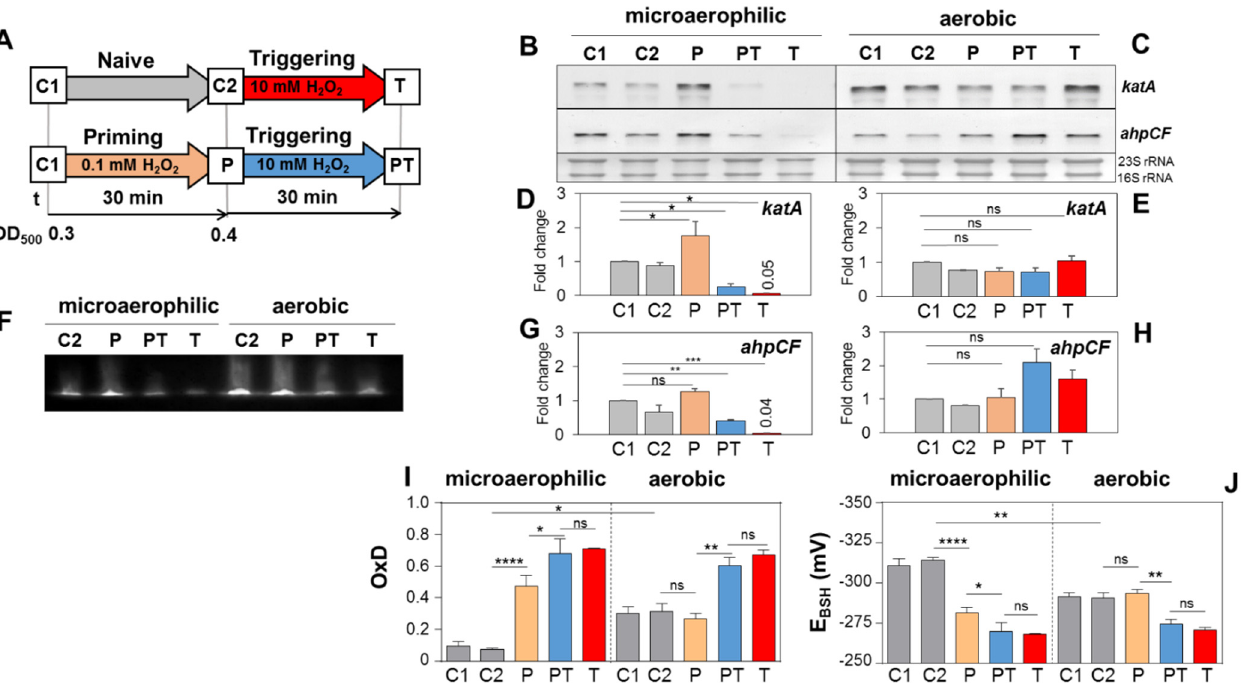
Figure 5. Microaerophilic H 2 O 2 priming leads to increased katA transcription and KatA activity, as well as fast Brx-roGFP2 biosensor oxidation. ( A ) The setup for microaerophilic and aerobic priming and triggering experiments included priming with 0.1 mM H 2 O 2 and triggering with 10 mM H 2 O 2 . ( B , C ) To analyze transcription of katA and ahpCF using Northern blots, RNA was isolated from S. aureus WT cells in the naïve (C1, C2), primed (P), primed and triggered (PT) and triggered (T) states. The band intensities of the katA ( D , E ) and ahpCF specific transcripts ( G , H ) were quantified from two biological replicates using ImageJ. The transcriptional induction of katA and ahpCF was calculated as fold change relative to the control C1, which was set to 1. Error bars represent the SD. The statistics were calculated using ordinary one-way ANOVA and Dunnet’s multiple comparisons test in Graph Prism. Symbols: ns p > 0.05; * p ≤ 0.05; ** p ≤ 0.01 and *** p ≤ 0.001. ( F ) The catalase activity was analysed in cell extracts of the S. aureus WT during microaerophilic and aerobic H 2 O 2 priming for C2, P, PT and T states using native PAGE and diaminobenzidine staining. The catalase activity assays were performed in two biological and two technical replicates. ( I , J ) The response of the Brx-roGFP2 biosensor was measured in S. aureus COL grown in LB medium under microaerophilic and aerobic conditions in naïve (C1, C2), primed (P), primed and triggered (PT) and triggered (T) cells. The C1 and C2 samples were harvested at OD 500 of 0.3 and 0.4, respectively, and the P, PT and T bacteria were harvested after 10 min of H 2 O 2 exposure (maximum biosensor oxidation). Samples were blocked with 10 mM NEM and the fluorescence excitation maxima were measured at 405 and 488 nm using the microplate reader. OxD values and the E BSH of Brx-roGFP2 were calculated using the 405/408 nm excitation ratio, as described in the Materials and Methods section. Mean values of three biological replicates are shown, error bars represent the SD and p -values were calculated using Student’s unpaired two-tailed t-test in Graph Prism software. Symbols: ns p > 0.05; * p ≤ 0.05; ** p ≤ 0.01; *** p ≤ 0.001 and *** p ≤ 0.0001.